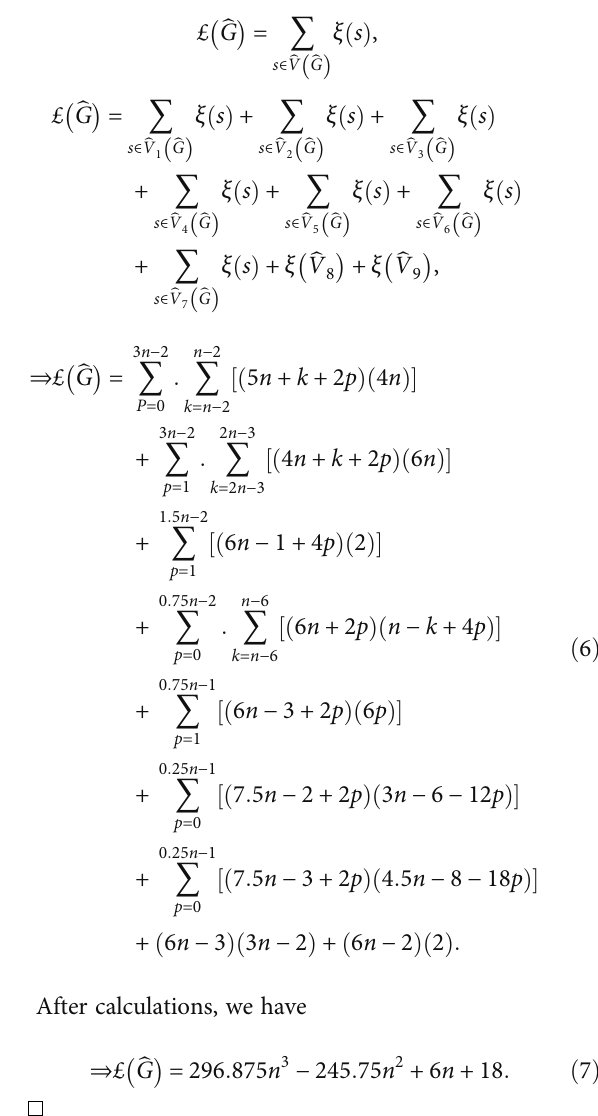
Figure 1: Dominating David-derived network of the fi rst type D ð 2 Þ